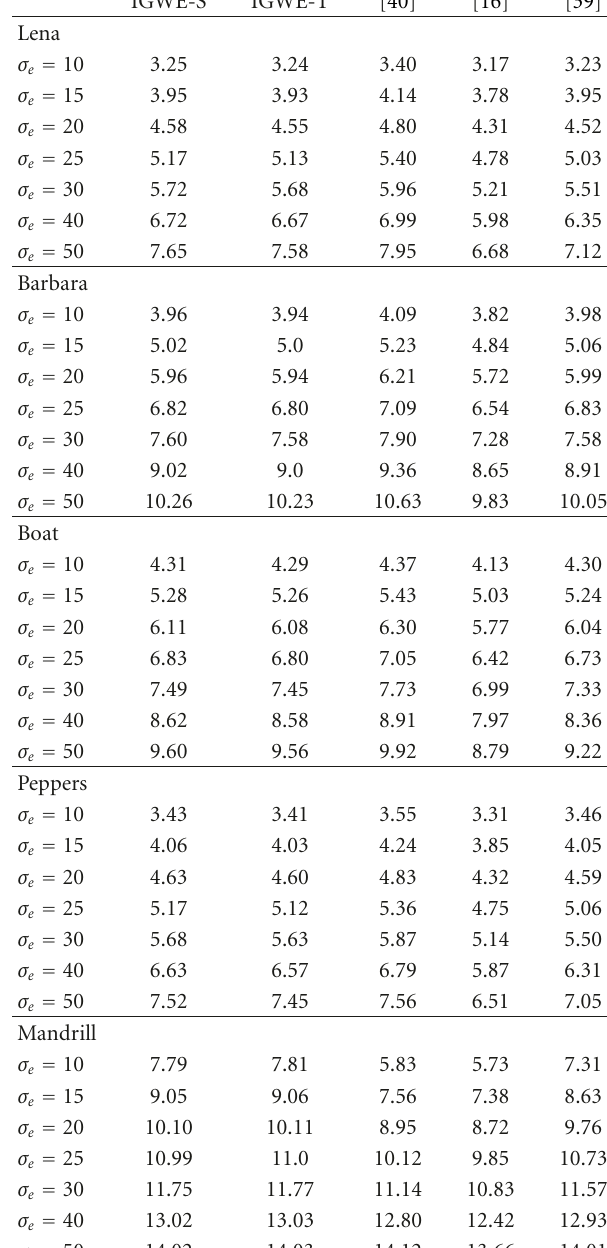
Table 4: A comparison of denoising results based on the peak- signal-to-noise ratio (dB). Five test images are used under di ff erent noise levels. It should be noted that results due to references [16, 39, 40] are calculated using the available software from the authors. These results may be slightly di ff erent from those presented in the original paper.